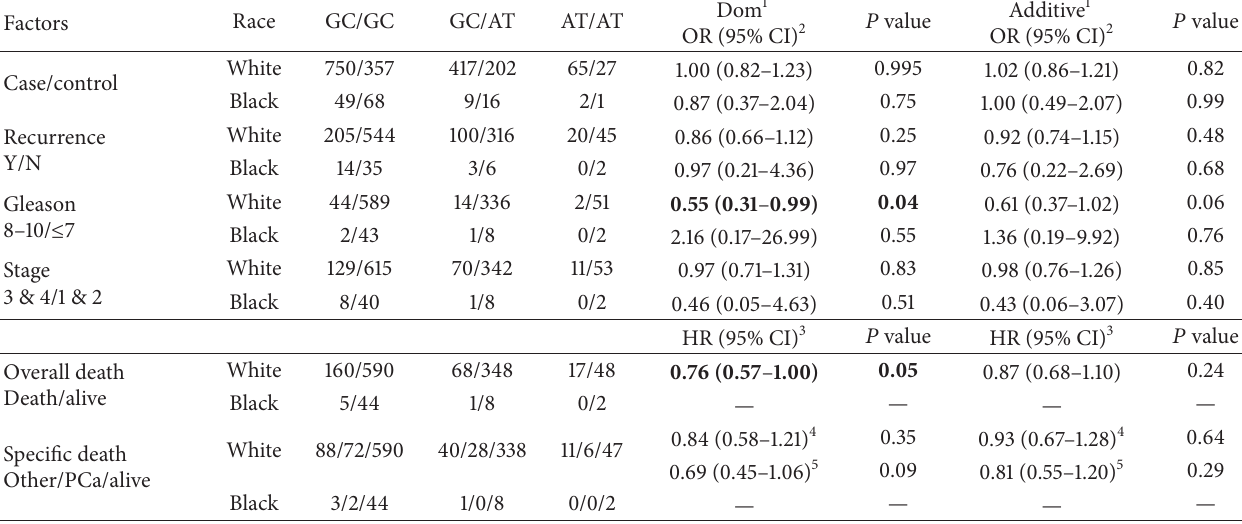
Table 2: Associations of genotypes with prostate cancer risk, aggressiveness, and survival.